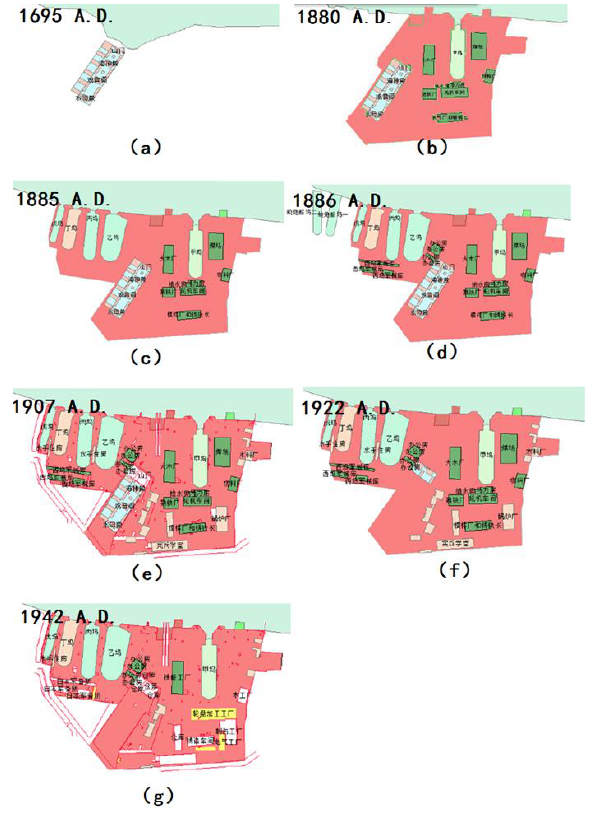
Figure 8. Historial development map of Dagu dock (1695-1942